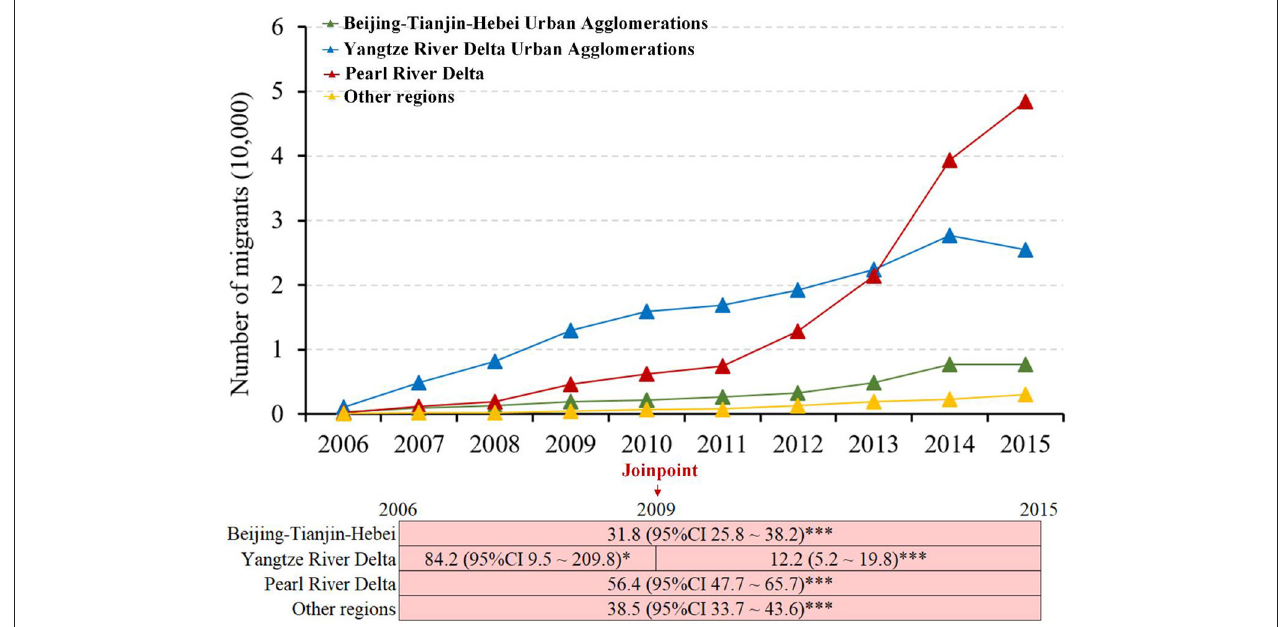
FIGURE 3 | Trends in the annual number of migrant methamphetamine use cases, stratified by destination geographical areas: 2006–2015 in the mainland of China (*indicated p < 0.05; ***indicated p < 0.001).